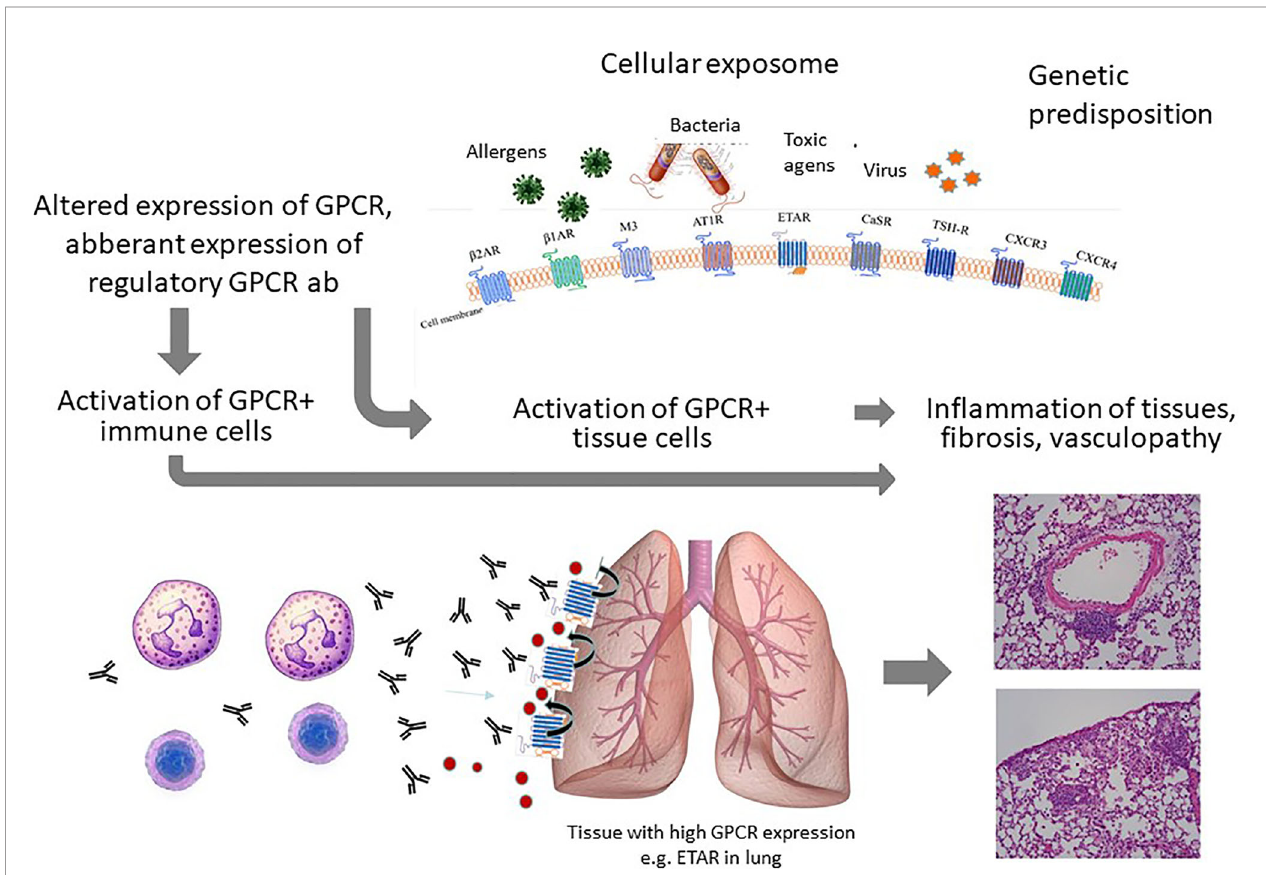
FIGURE 2 | Summary of the concept: The chronic cellular exposome leads to an altered GPCR and GPCR ab signature. The ab effects on activation/migration of immune cells as well as tissue resident cells will lead to in fl ammation and vasculopathy as illustrated here for the